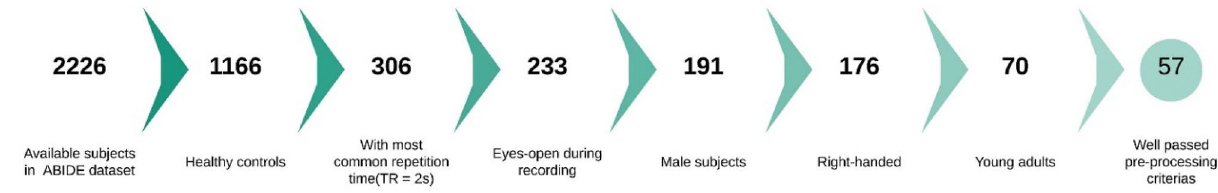
Figure 8. Subject selection